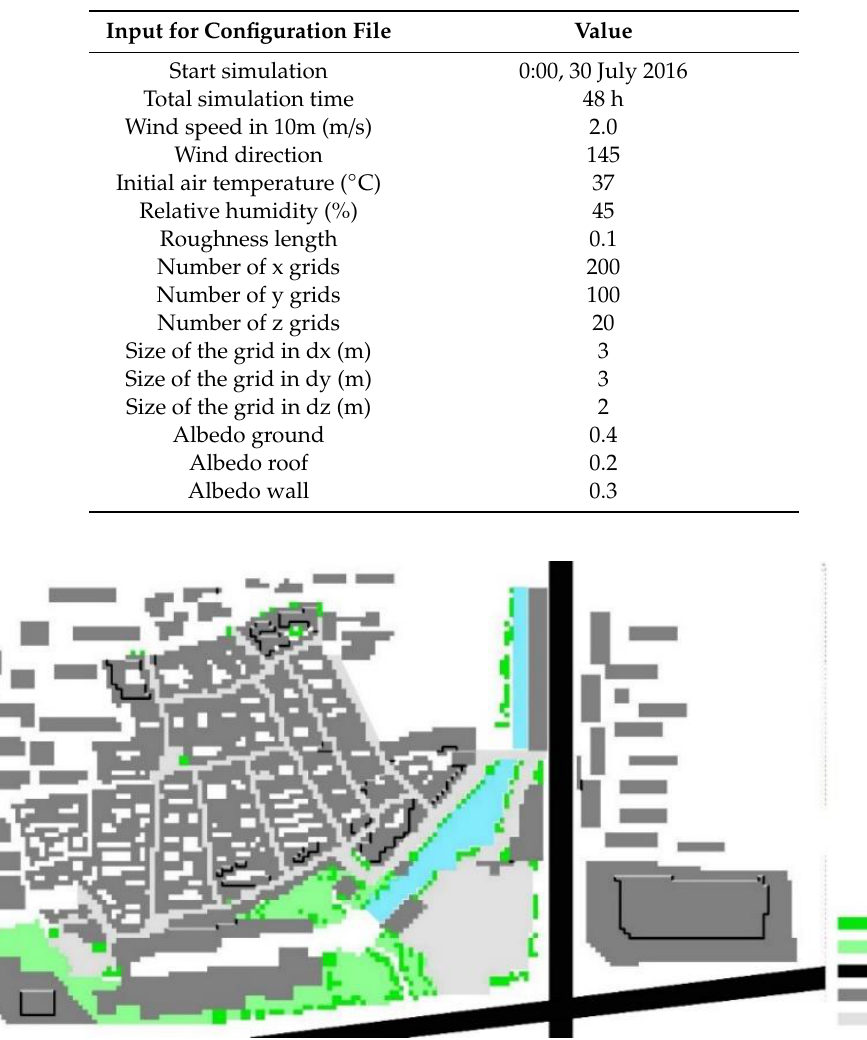
Table 5. Initial simulated data for ENVI-met. Figure 7. Schematic of grass database model for ENVI-met. Figure 7. Schematic of grass database model for ENVI-met.